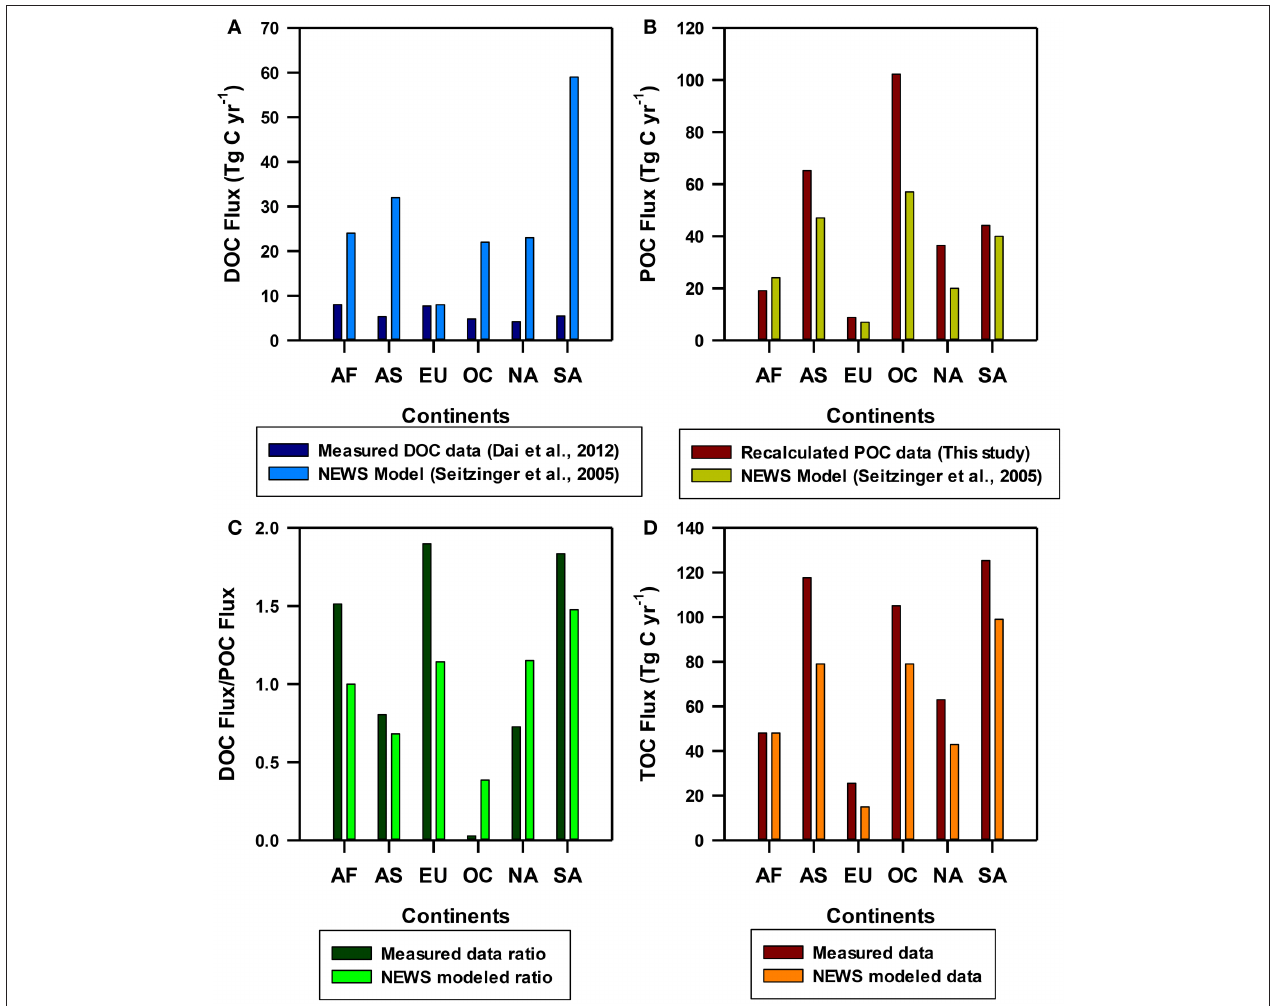
FIGURE 3 | Continent-wise (A) spatial distribution of dissolved organic carbon (DOC) fluxes reproduced from Dai et al. (2012) (dark blue) compared with the predicted fluxes of NEWS (Global Nutrient Export from Watersheds) models from Seitzinger et al. (2005) (blue); (B) spatial distribution of particulate organic carbon (POC) fluxes recalculated from Huang et al. (2012) (dark red) compared with the NEWS predicted values from Seitzinger et al. (2005) (dark yellow); (C) DOC/POC fluxes ratios from the measured data (dark green) compared with similar ratios of NEWS models (light green); (D) spatial distribution of total organic carbon (TOC) fluxes recalculated in this study (dark red) compared with the POC fluxes predicted by NEWS models (dark orange). AF, Africa; AS, Asia; EU, Europe; OC, Oceania; NA, North America; SA, South